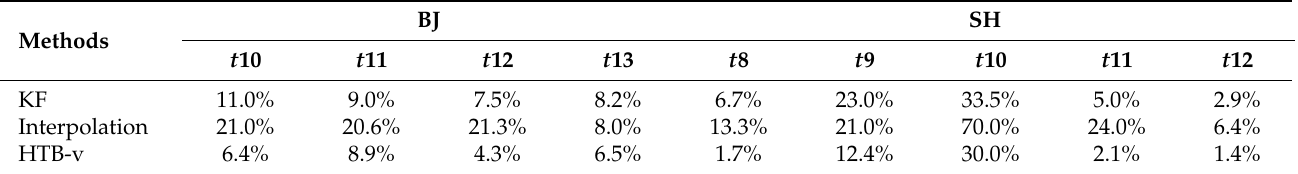
Table 4. The error rate φ of the three